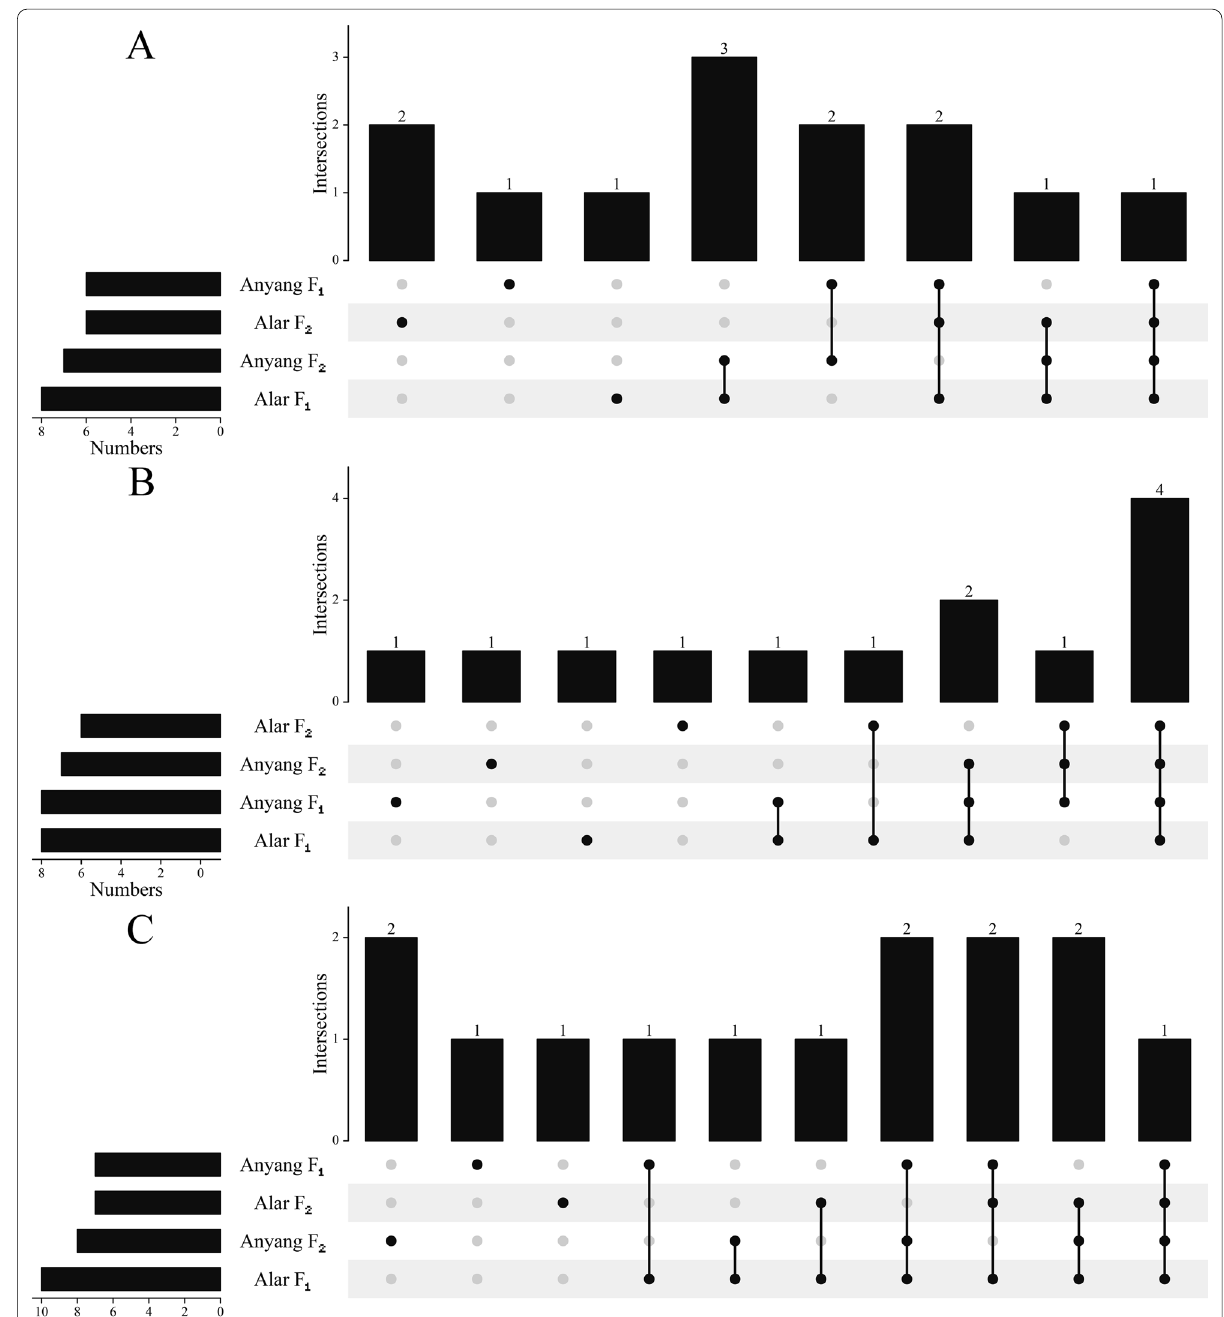
Fig. 1 Upset plot showing the details of the top eight hybrid combinations in BPH ( A ), CH ( B ), and MPH ( C ) for the F 1 and F 2 traits of the two environments. The connection of the black circle in the figure represents the intersection between the different groups, and the number of intersections is correspondingly represented in the upper bar